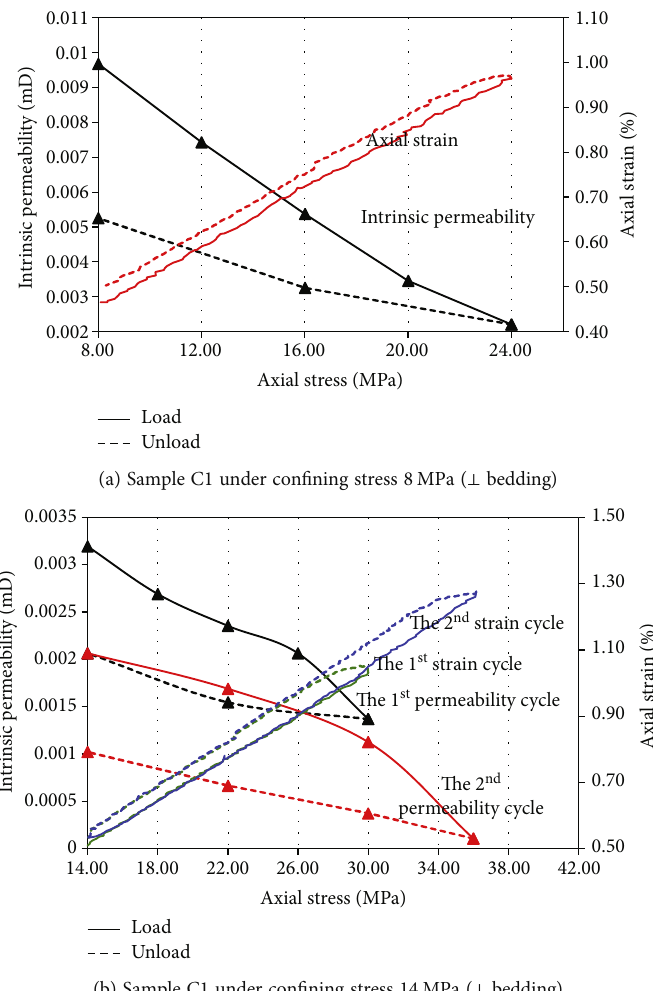
Figure 7: Coal intrinsic permeability evolution under deviatoric stresses.